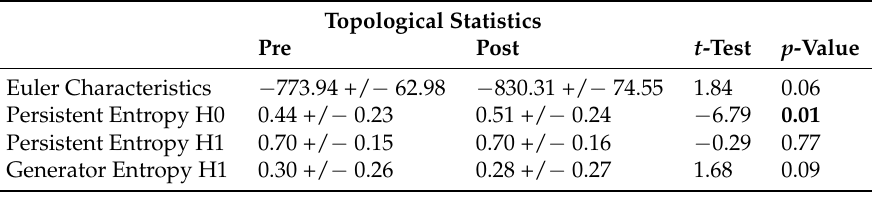
Figure 11. Analysis of temporal properties of for quiescent and necrotic cells for different α = [ 0.0,0.5,1.0 ] . ( Left ) quiescent, ( right ) necrotic. Table 1. Statistical analysis of topological features for tumor progression analysis.